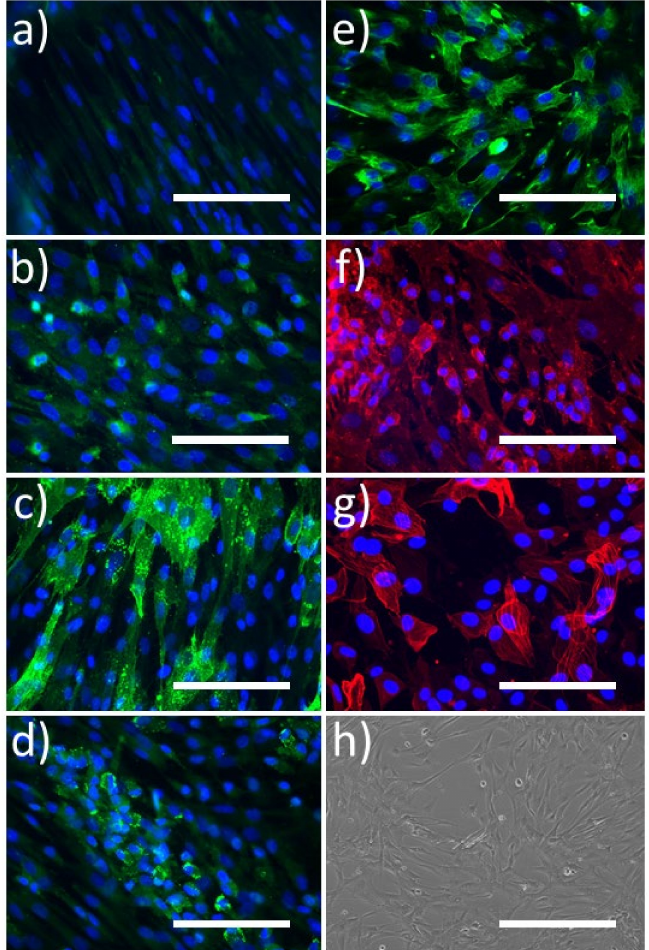
Figure 2. Representative images of porcine blood outgrowth cells (BOC) stained for common endothe- lial cell markers (green; ( a – e )) and mesenchymal cell markers (red; ( f , g )): ( a ) CD31, ( b ) VE-Cadherin, ( c ) DBA-Lectin, ( d ) von Willebrand factor (vWF), ( e ) vimentin, ( f ) CD90/Thy-1, ( g ) α -smooth muscle actin, ( h ) phase contrast image of blood outgrowth cells showing spindle-like morphology. Nuclei are stained with DAPI (blue). All bars represent 400 µ